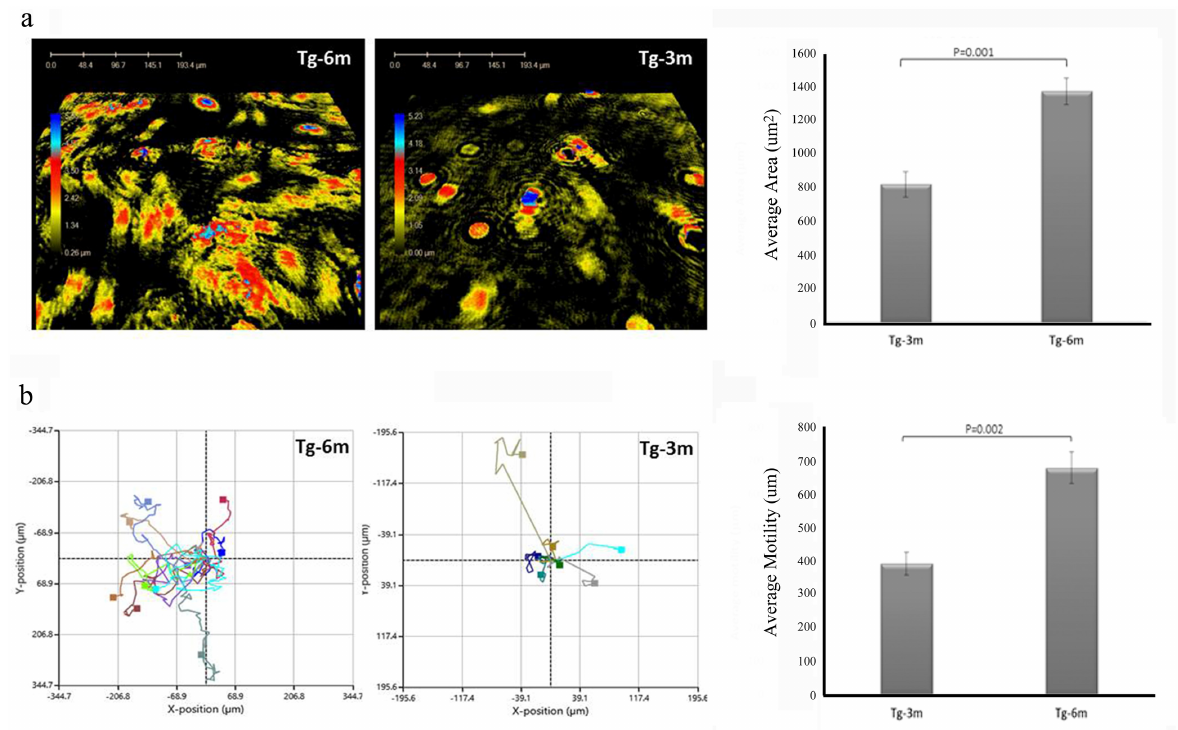
Fig 5. Holographic microscopy analysis of cellular movement. Six-month (Tg-6m) cells were more versatilecompared to Tg-3m cells in the captured image. Surface areas of Tg-3m and Tg-6m cells were measuredand statistically plotted in a bar chart ( μ m 2 ). (b) The paths of cell migration are presented as individual colored lines from Tg-3m and Tg-6m cells, and the averagemotility was calculatedin the bar chart ( μ m). The Fig showed representativeresults of 3 independent experiments.